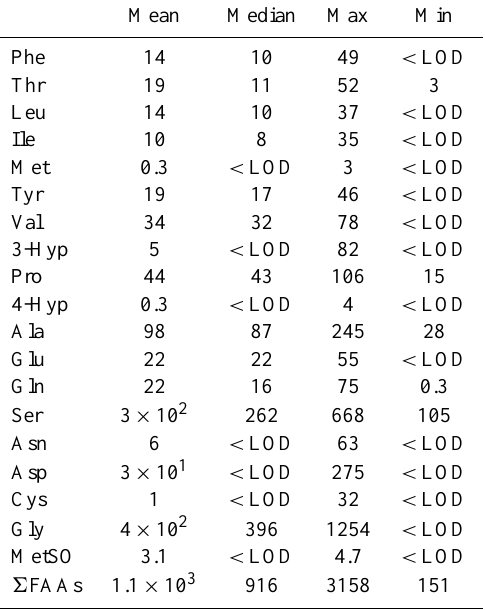
Table 3. Mean, median, maximum and minimum values of amino acids in Arctic background ( < 0.49µm) filters (fmolm − 3